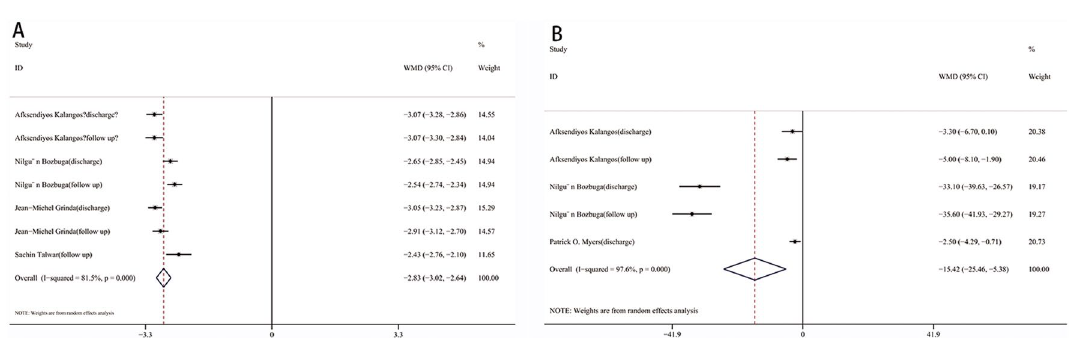
Figure 2. Forest plot of pooled hospital mortality ( A ), 5-year survival ( B ) and 5-year reoperation rates ( C ). ES effect size, CI confidence interval.